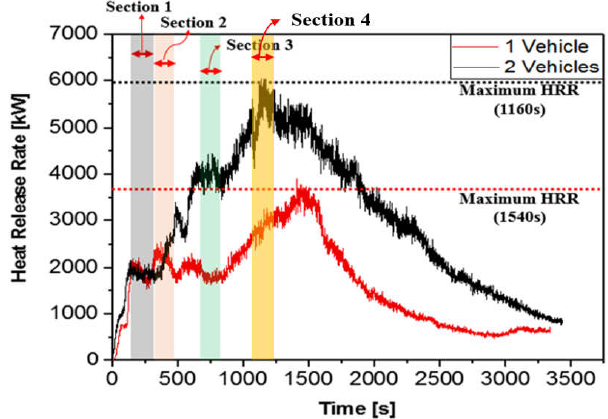
Figure 11. Heat release rate for one and two vehicles as a function of time.